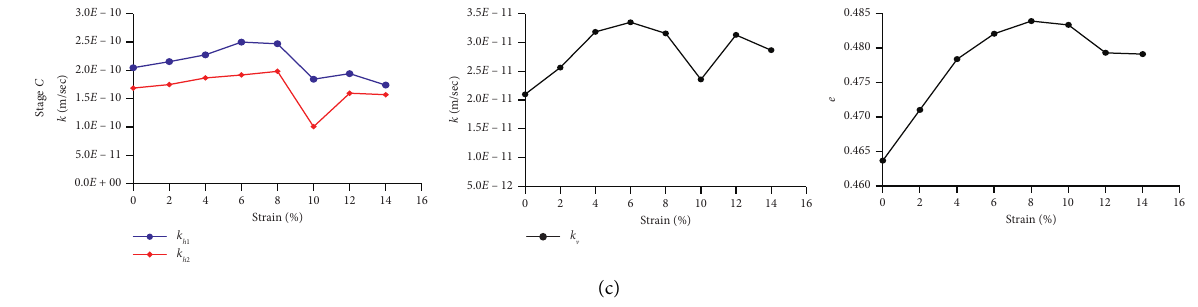
k v , and e vs. strain for each stage of sample ΙΙ . h 1 , k h 2 ,